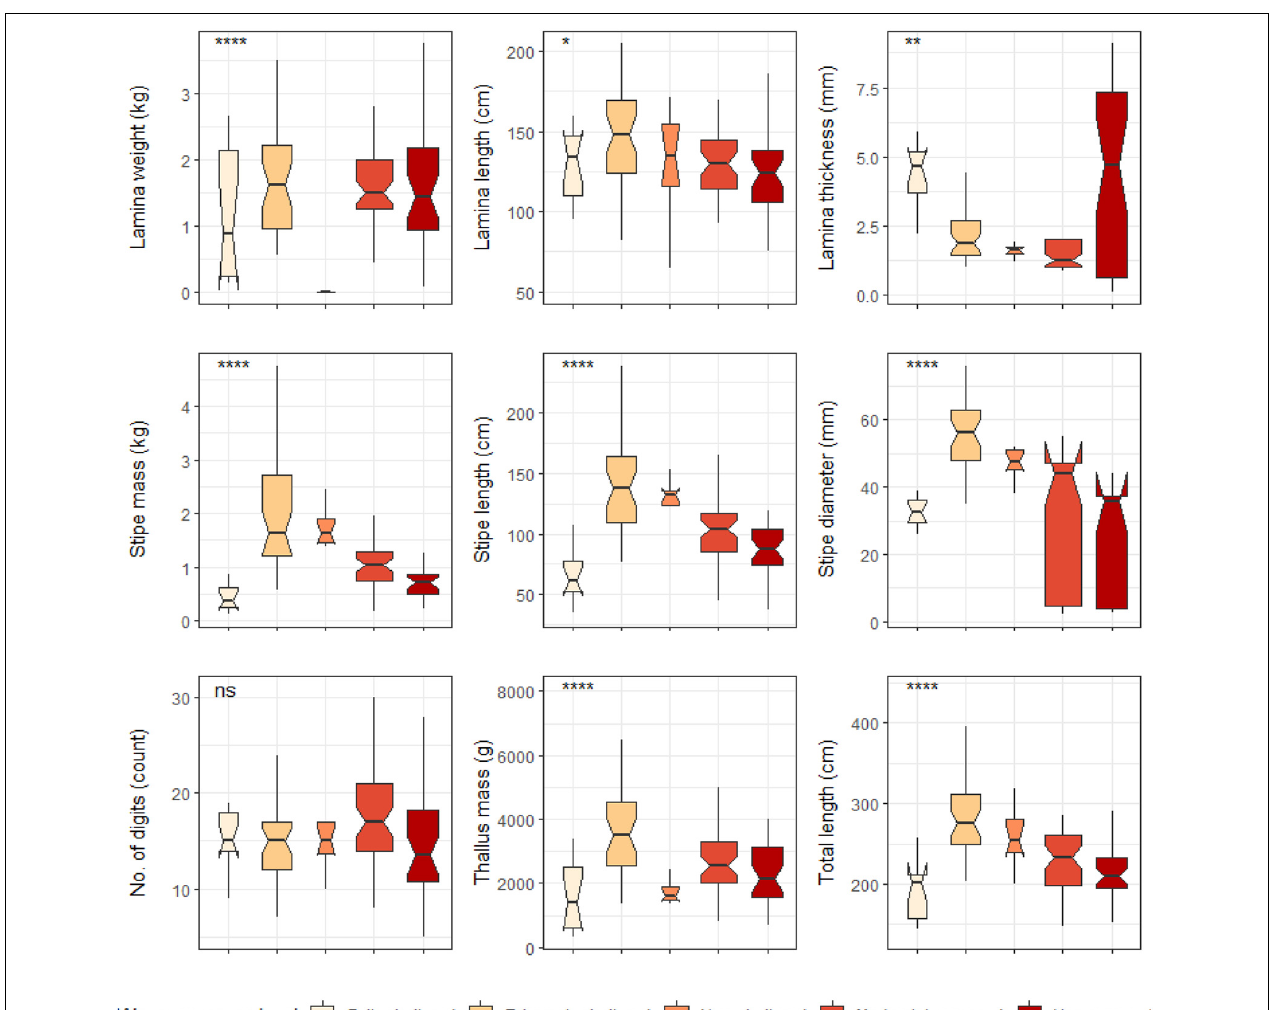
FIGURE 7 | Boxplots representing L. pallida morphological characteristics grouped by wave exposure category measured around the Western Cape coastline, with the y -axis depicting the specific morphology measured, with units provided. The lower and upper hinges correspond to the first and third quartiles. The whiskers represent the range, solid black lines represent the median and black dots are outliers. Significance levels are as follows: * represents ≤ 0.05, ** represents ≤ 0.01, *** represents ≤ 0.001, **** represents ≤